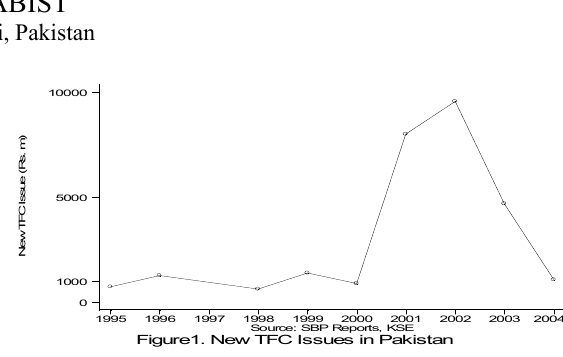
KSE1995 1996 1997 1998 1999 2000 2001 2002 2003 Figure1. New TFC Issues in Pakistan Source: SBP Reports,